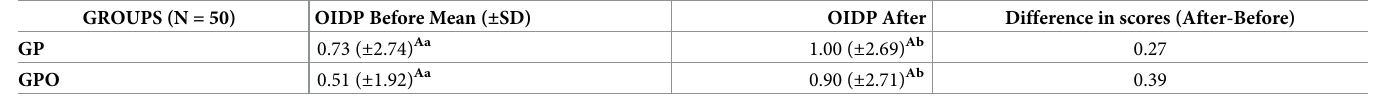
� Different capital letters represent a statistically significant intergroup difference, according to the Wilcoxon Test (p � 0.05); � Different capital letters represent statistically significant intergroup difference (p � 0.05);